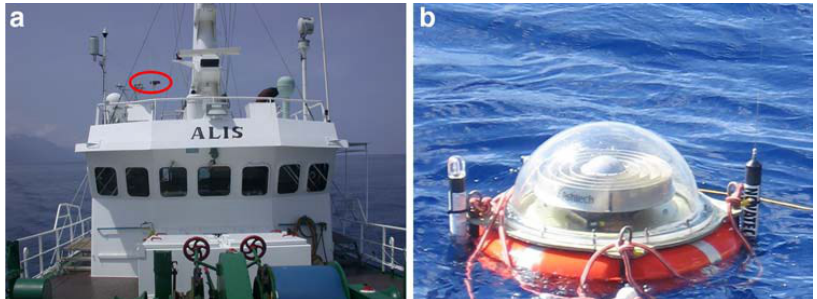
Figure 7. ( a ) Photograph of the ship with the GPS antenna (red ellipse), ( b ) photograph of the GPS buoy next to the ship [7].